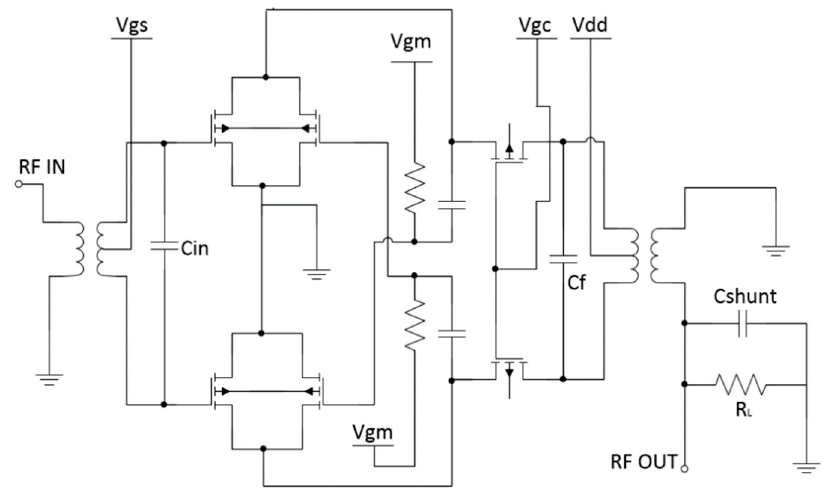
Figure 12. Schematic of mode-locking technique PA [42].